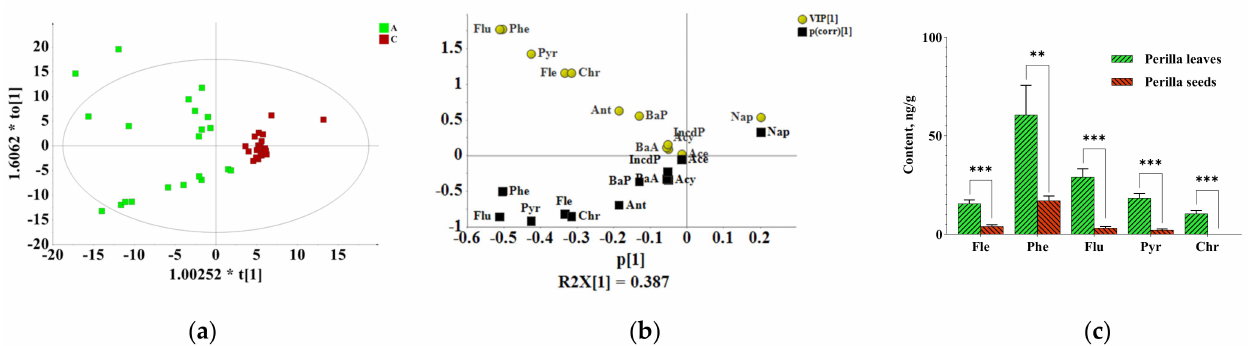
Figure 3. The difference between perilla leaves (A) and stems (B). ( a ) OPLS-DA score plot; ( b ) (V + S)- plot of OPLS-DA. ( c ) The contents of differential compounds ( C , ng/g) (**: p ≤ 0.01; ***: p ≤ 0.001).